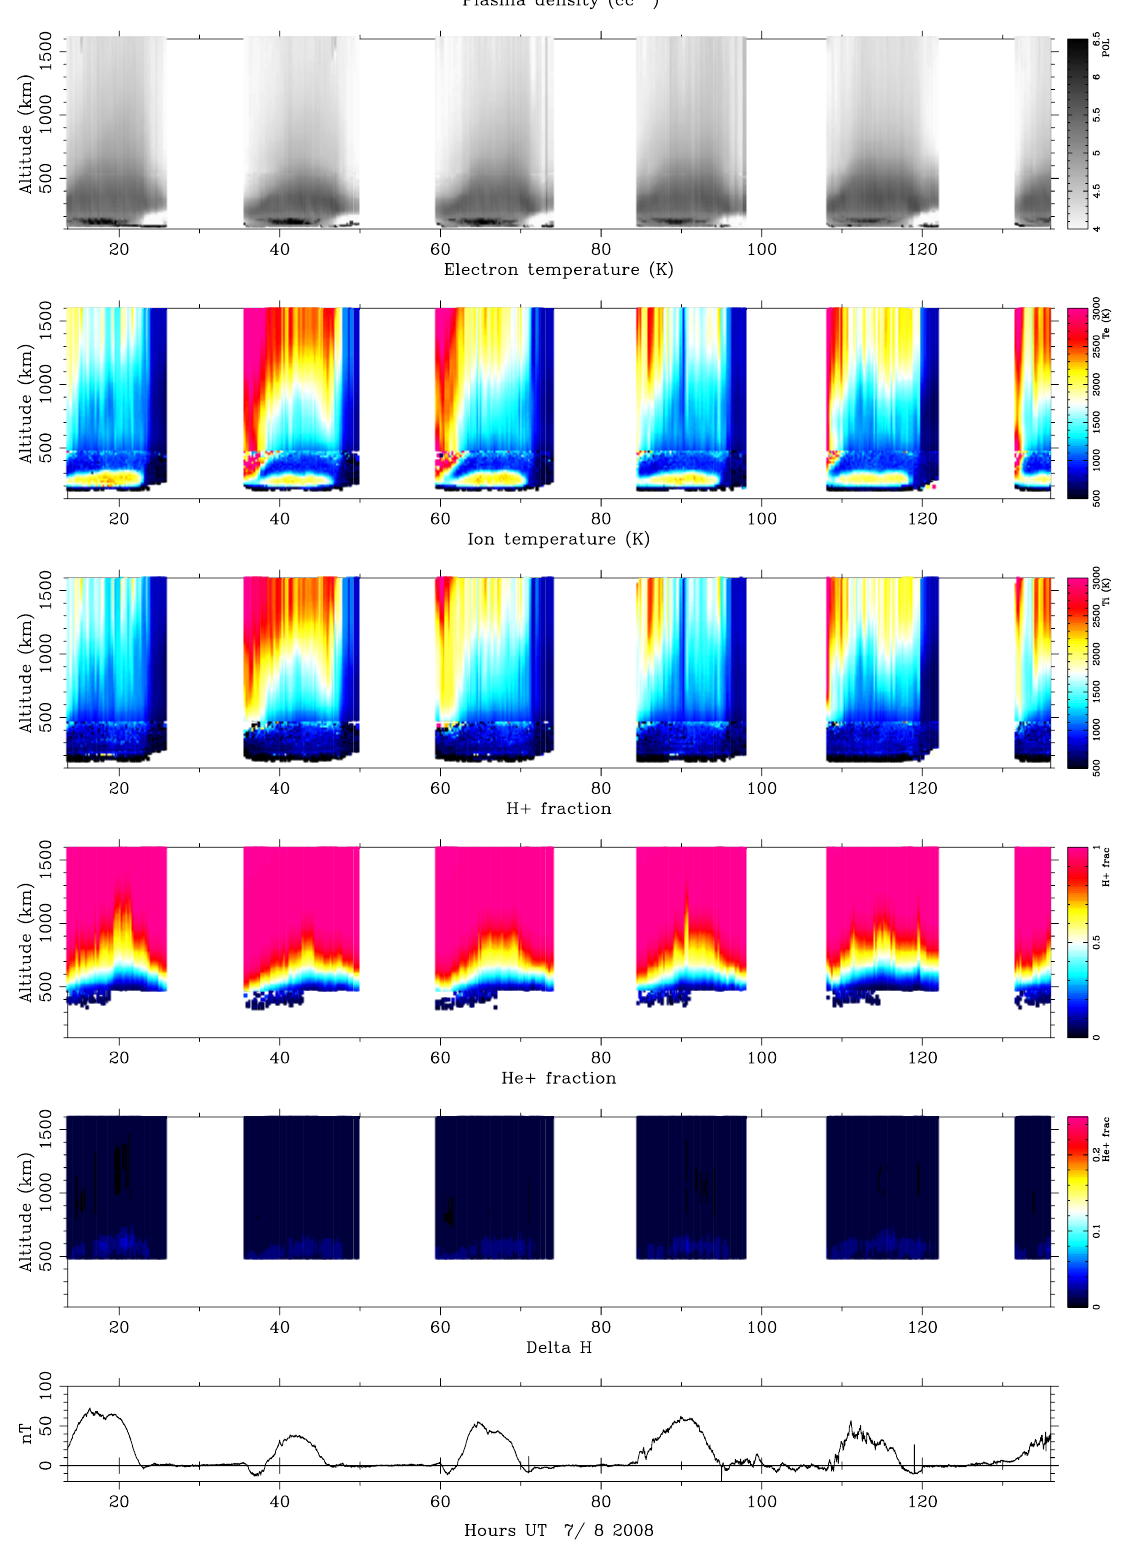
Fig. 5. Full-profile results for the July 2008 World Day period. From top to bottom, the rows depict plasma number density, electron temperature, ion temperature, hydrogen ion fraction, helium ion fraction, and the H component of the magnetic field due to the